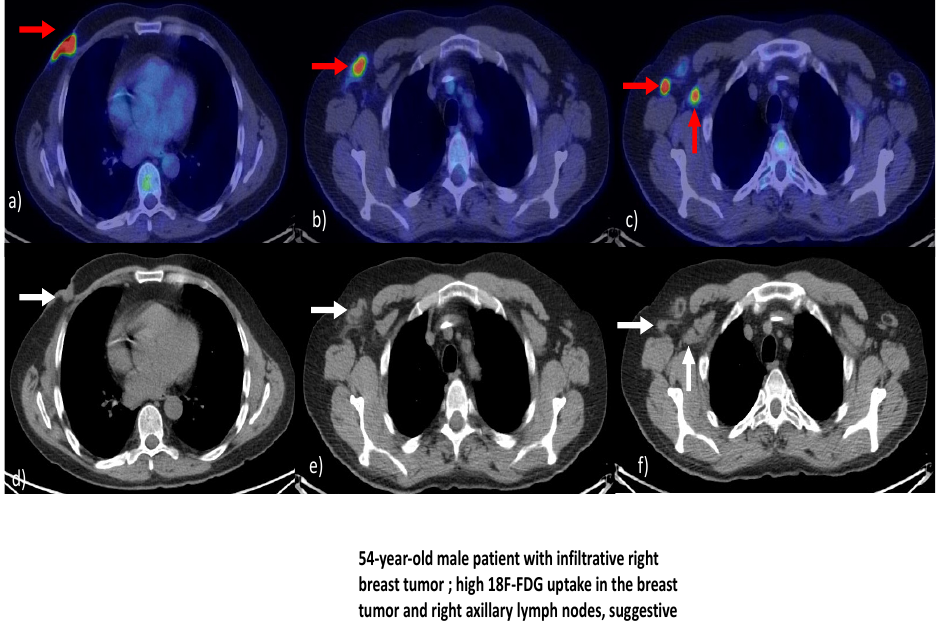
Figure 1. ( a – f ) Subsets illustrating PET-CT/ low dose CT aspects of male breast tumors. Courtesy of